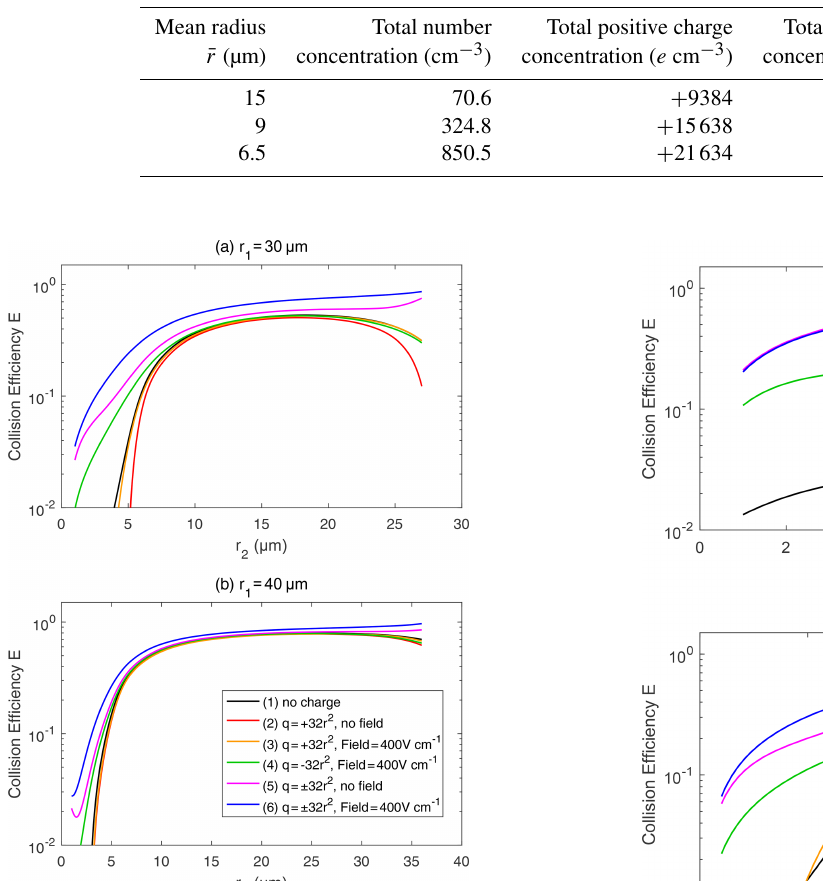
Table 1. Total number concentration and charge content for all initial droplet distributions.